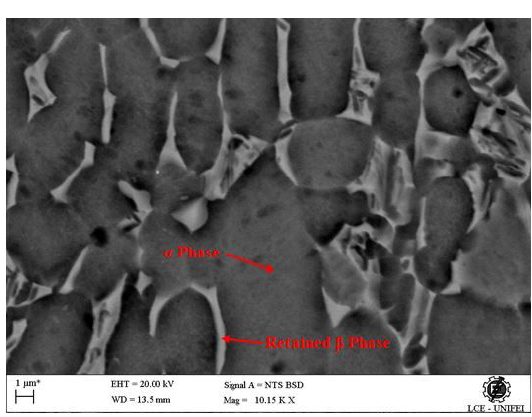
Figure 1. Specimen Dimensions.